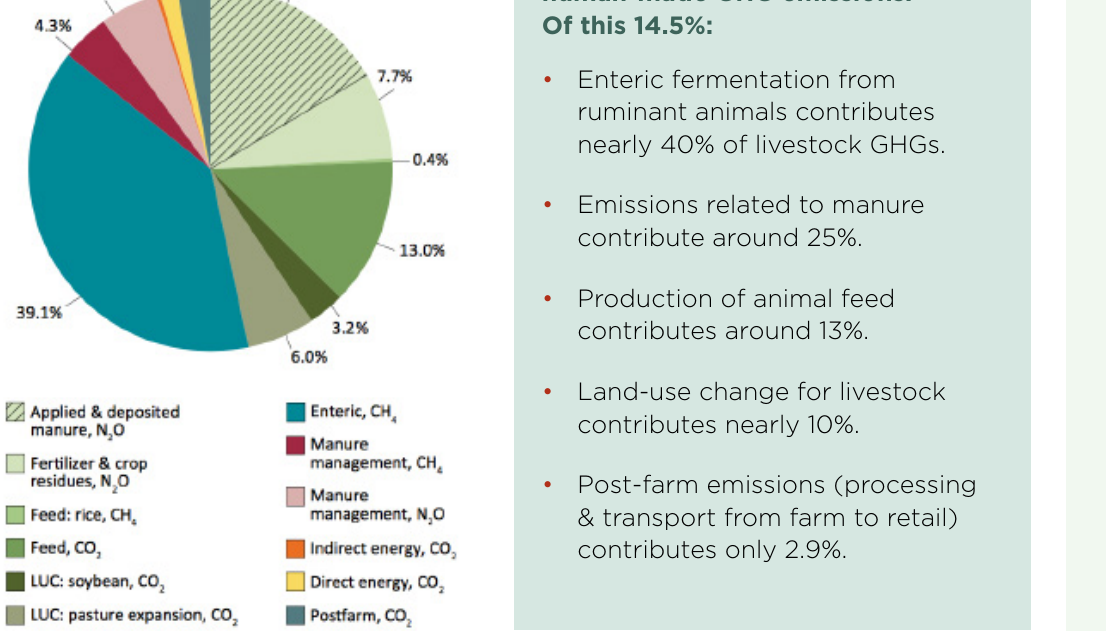
Figure 6: Total livestock-related emissions from direct and indirect sources. Source: Gerber, et al. (2013). Livestock contribute significantly to GHG emissions, but impacts of livestock are not limited only to GHG emissions.